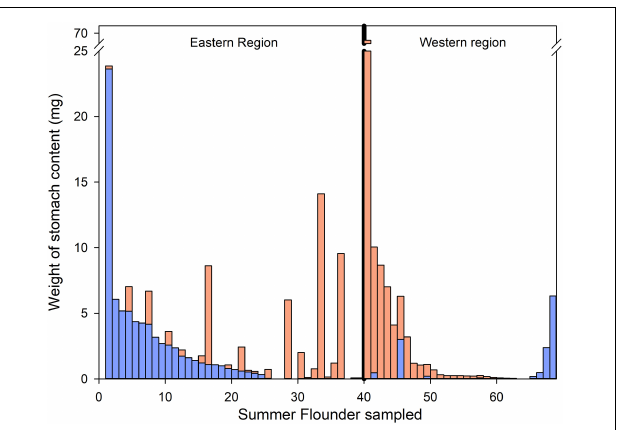
FIGURE 5 | Weight of total teleost (blue) and invertebrate (orange) prey found in the stomach of the sampled summer flounder divided by bay region (eastern and western